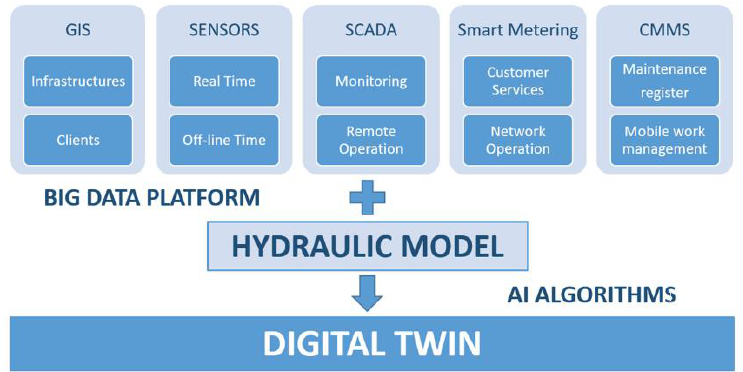
Figure 2. Structure of the proposed digital twin.